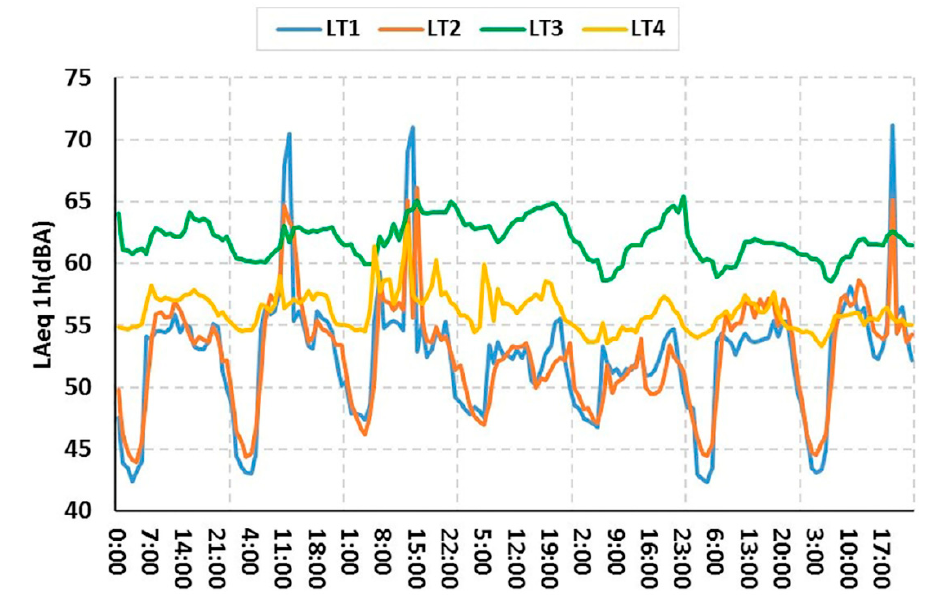
Figure 4. One h interval time evolution of L Aeq at the measuring points during the first week of long-term measurements.